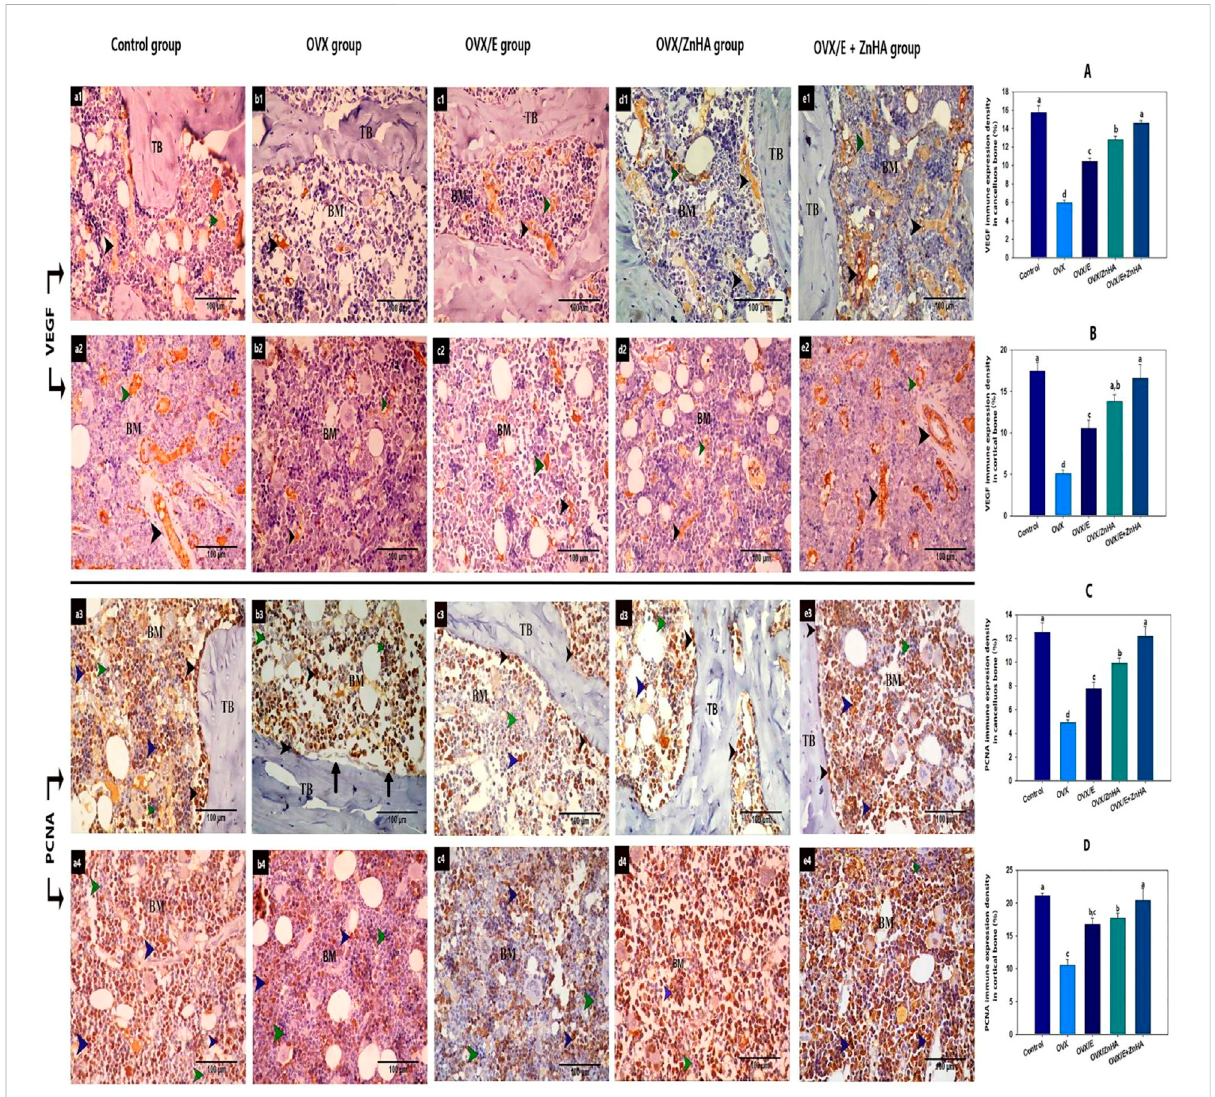
FIGURE 7 Immunohistochemical analyses of bone tissues for VEGF protein (a1,2- b1,2- c1,2- d1,2 and e1,2- and PCNA (a3,4-b3,4-c3,4- d3,4 and e3,4-) following estrogen (E2) and/or zinc hydroxyapatite nanoparticles (ZnHA-NPs) in ovariectomized (OVX) rats. VEGF was detected in blood vessels of bonemarrow(blackarrowhead)andsomehematopoieticcells(greenarrowhead).PCNAexpressionwasdetectedinosteoblastsorosteogeniccells (blackarrowhead)andsomecellsinbonemarrow(bluearrowhead).NotethattherearesomePCNA-negativebonemarrowcells(greenarrow head). (a1,3-b1,3-c1,3-d1,3- and e1,3) trabecular bone from control, OVX, OVX/E, OVX/ZnHA and OVX/E+ZnHA groups respectively. (a2,4-b2,4- c2,4-d2,4 and e2,4) cortical bone marrow from control, OVX, OVX/E, OVX/ZnHA and OVX/E+ZnHA groups, respectively. Histomorphometric analysis (A-D) were expressed as mean ± SME ( n = 5/group, triplicate). Bars carrying different superscripts are signi fi cantly different ( p <